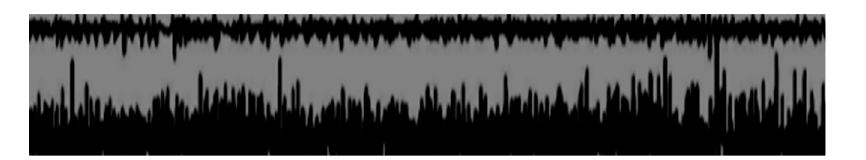
Figure 1. Multi dynamic Electromyography (EMG). Trace 1: Extensor pollicis brevis. Trace 2: Abductor pollicis longus. This clinical case can be viewed in the video (Supplementary Material).